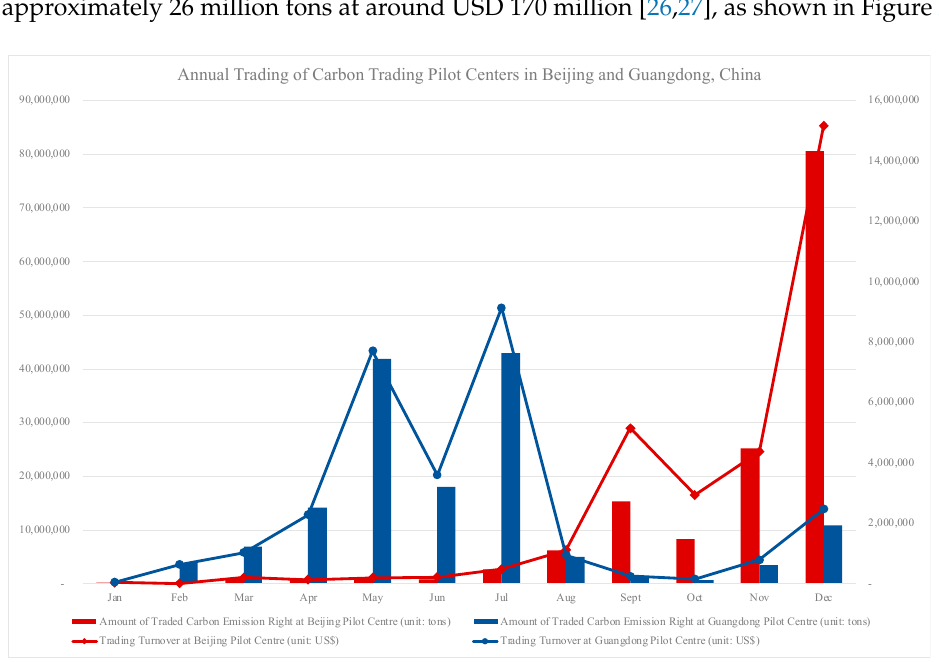
Amount of Traded Carbon Emission Right at Beijing Pilot Centre (unit: tons) Amount of Traded Carbon Emission Right at Guangdong Pilot Centre (unit: tons) Trading Turnover at Beijing Pilot Centre (unit: US$) Trading Turnover at Guangdong Pilot Centre (unit: US$) Figure 2. Annual turnover of carbon trading pilot centres in China in 2021.